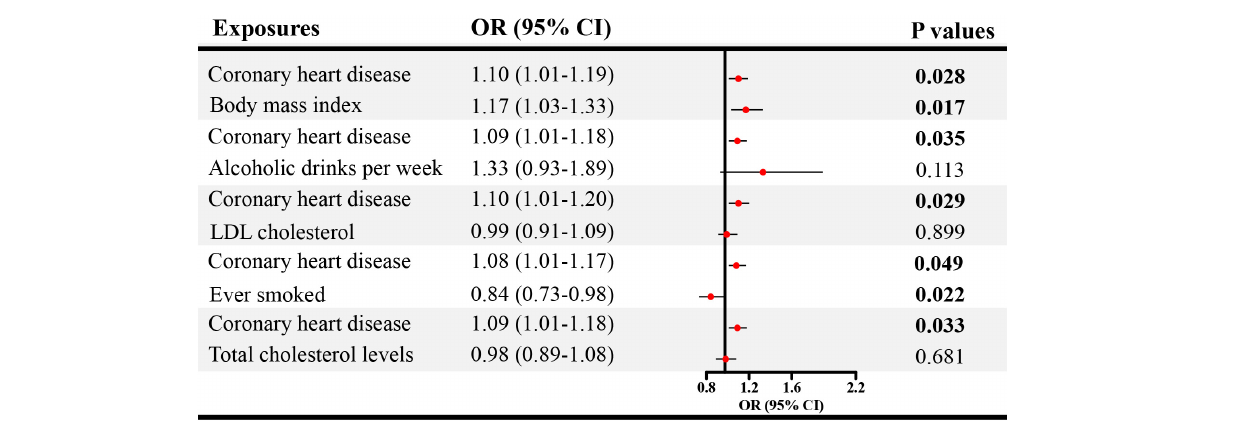
FIGURE4 The direct causal effects of CHD on ED in MVMR. CHD, coronary heart disease; MVMR, multivariable Mendelian randomization; OR, odds ratio; CI, confidence interval.